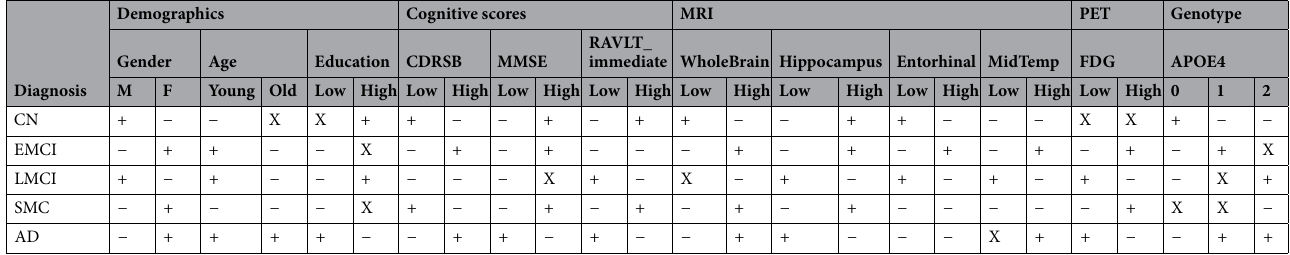
Table 6. Merged scheme showing the influence of each feature on each of the diagnosis.